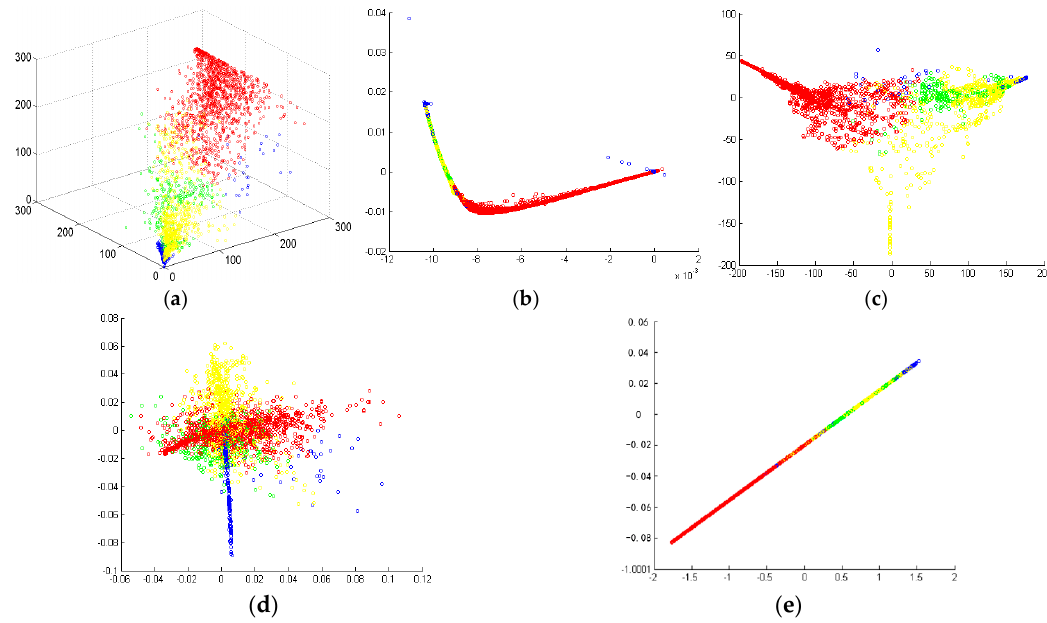
Figure 9. Feature dimensional reduction performance with four different methods: ( a ) original improved MCSM decomposition scattering powers in the 3-D space; ( b ) two-dimensional embedding by the LLE; ( c ) two-dimensional embedding by the LE; ( d ) two-dimensional embedding by the LTSA; ( e ) two-dimensional embedding by the S-LLE (red: urban areas; green: vegetated areas; blue: water areas; yellow: bare soil areas).